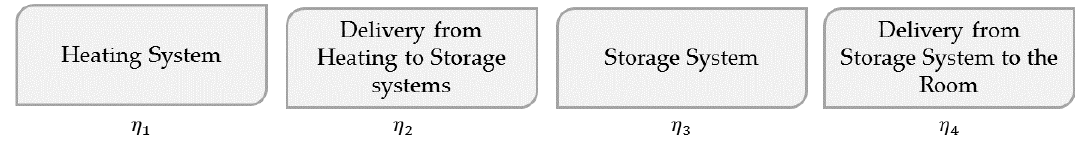
Figure 6. Components of a heating system with a storage system and their efficiency.